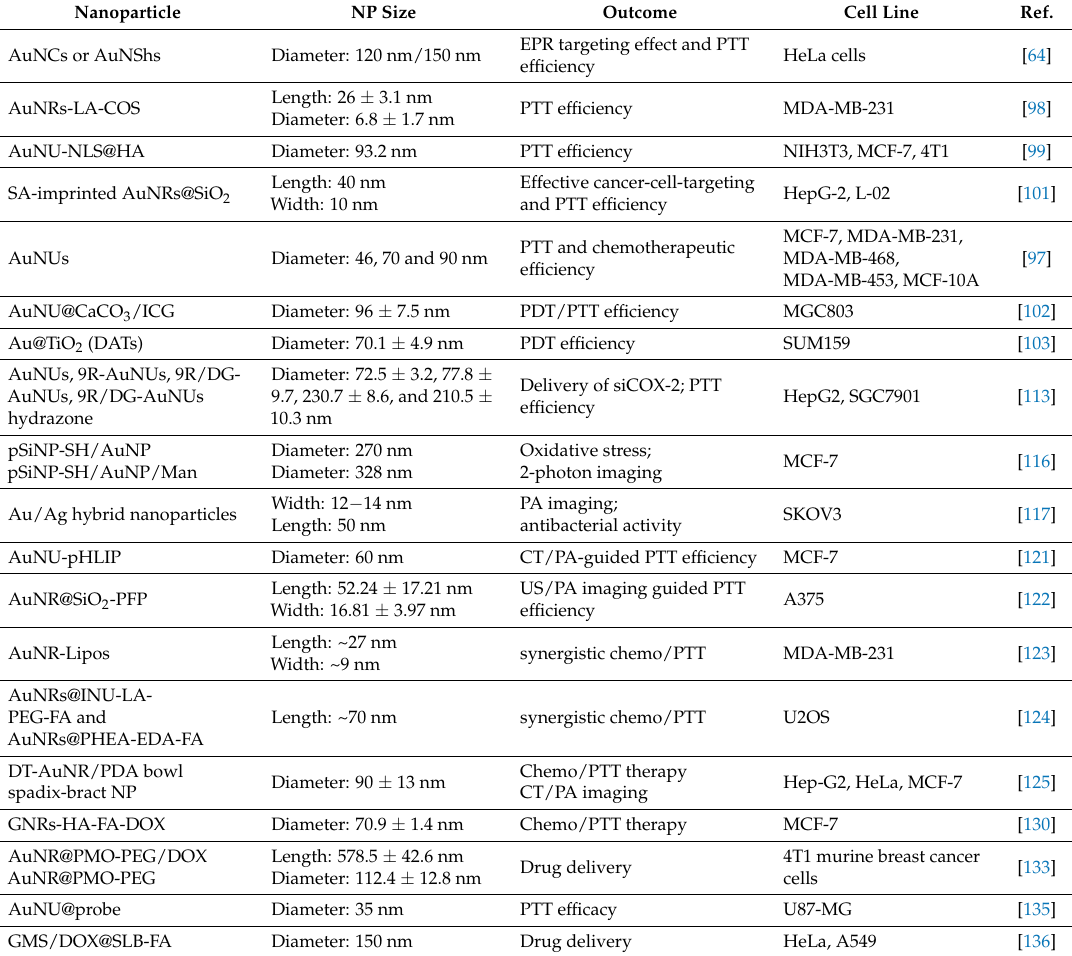
Table 2. Overview of anisotropic gold nanosystem for therapeutics and imaging. Nanoparticle NP Size